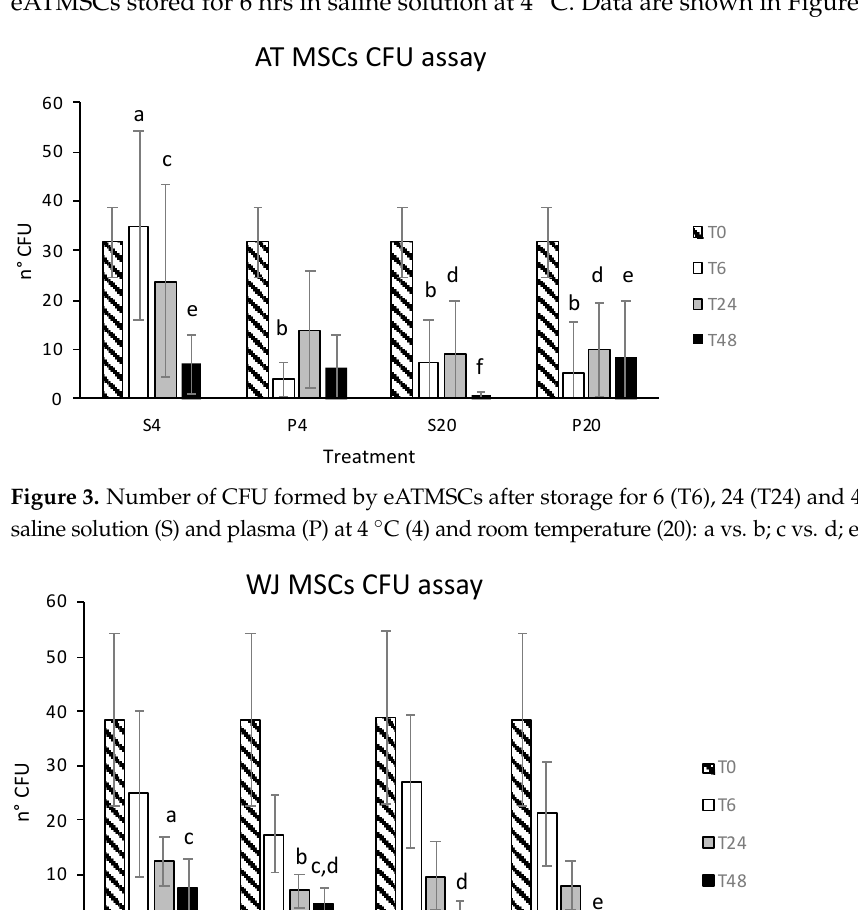
Figure 2. eWJMSCs viability after storage for 6 (T6), 24 (T24) and 48 (T48) hrs in saline solution (S) and plasma (P) at 4 °C (4) and room temperature (20). No statistical differences have been found among groups.